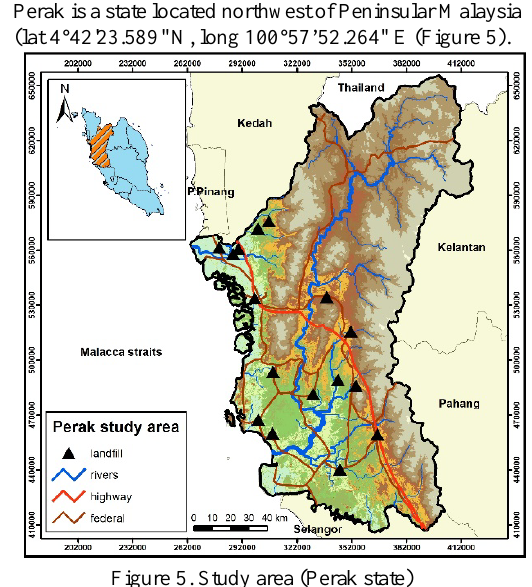
Figure 5. Study area (Perak